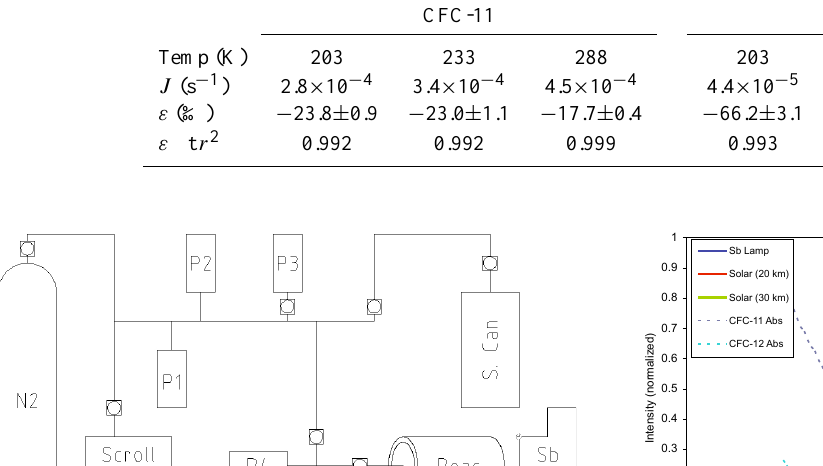
(VPDB) in per mil (‰). Details of calibration procedures are elaborated in Zuiderweg et al.